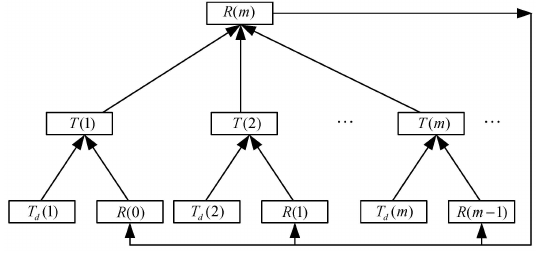
Figure 3. Iterative closed-loop computation model of reputation and